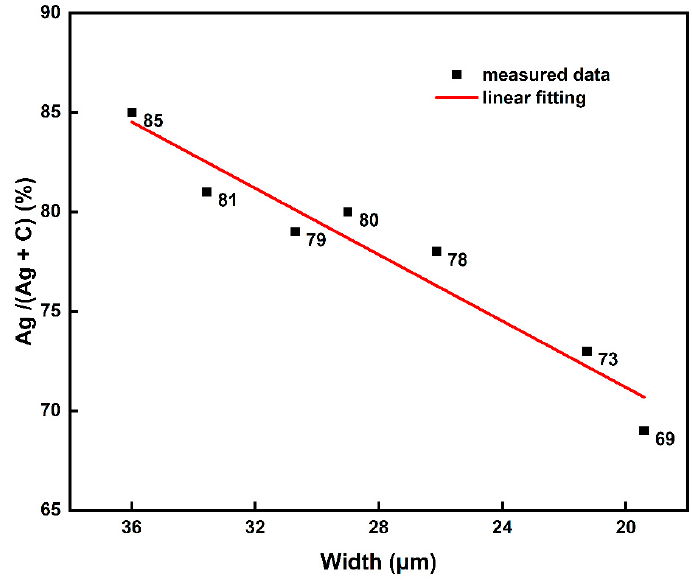
Figure 8. Relationship between silver/carbon content and line width.